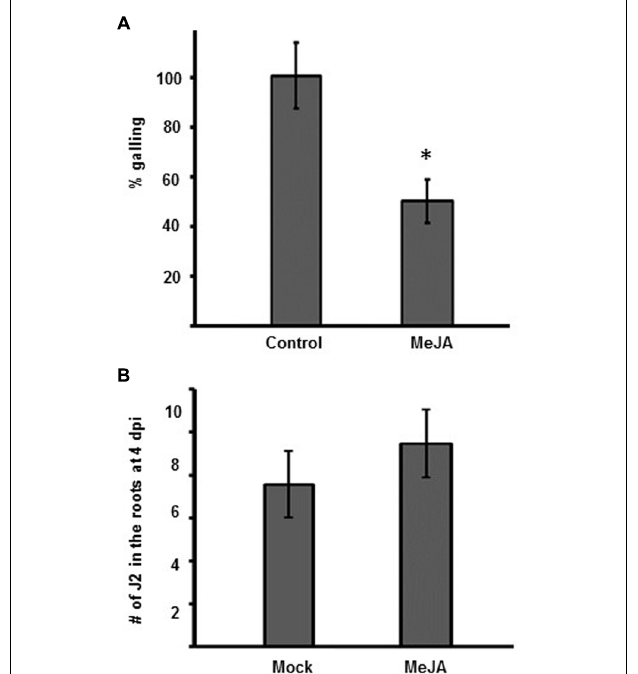
FIGURE 2 | Galling is reduced in Arabidopsis after MeJA. (A) Relative galling at 14 dpi in Col-0 plants with or without pre-treatment with MeJA. The galling in untreated Col-0 (Control) was set to 100%. Values show the mean ± SE of three independent experiments. Untreated control n = 235, MeJA n = 155. Asterisk indicates a significant different between control and treatment group (Welch t -test ∗ p < 0.005. (B) Number of J2 in the roots of plants, with or without 50 µ M MeJA pre-treatment, at 4 dpi. Values are the means ± SE from three independent experiments ( n = 15). No significant difference could be seen between mock and treatment group. Experiment repeated three times with similar